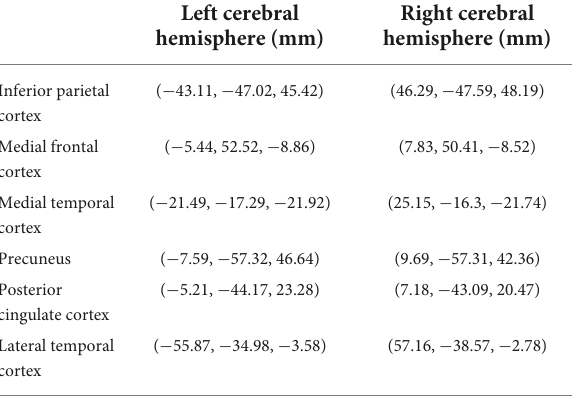
TABLE 1 MNI coordinates (x, y, z) of the center of each DMN-related brain